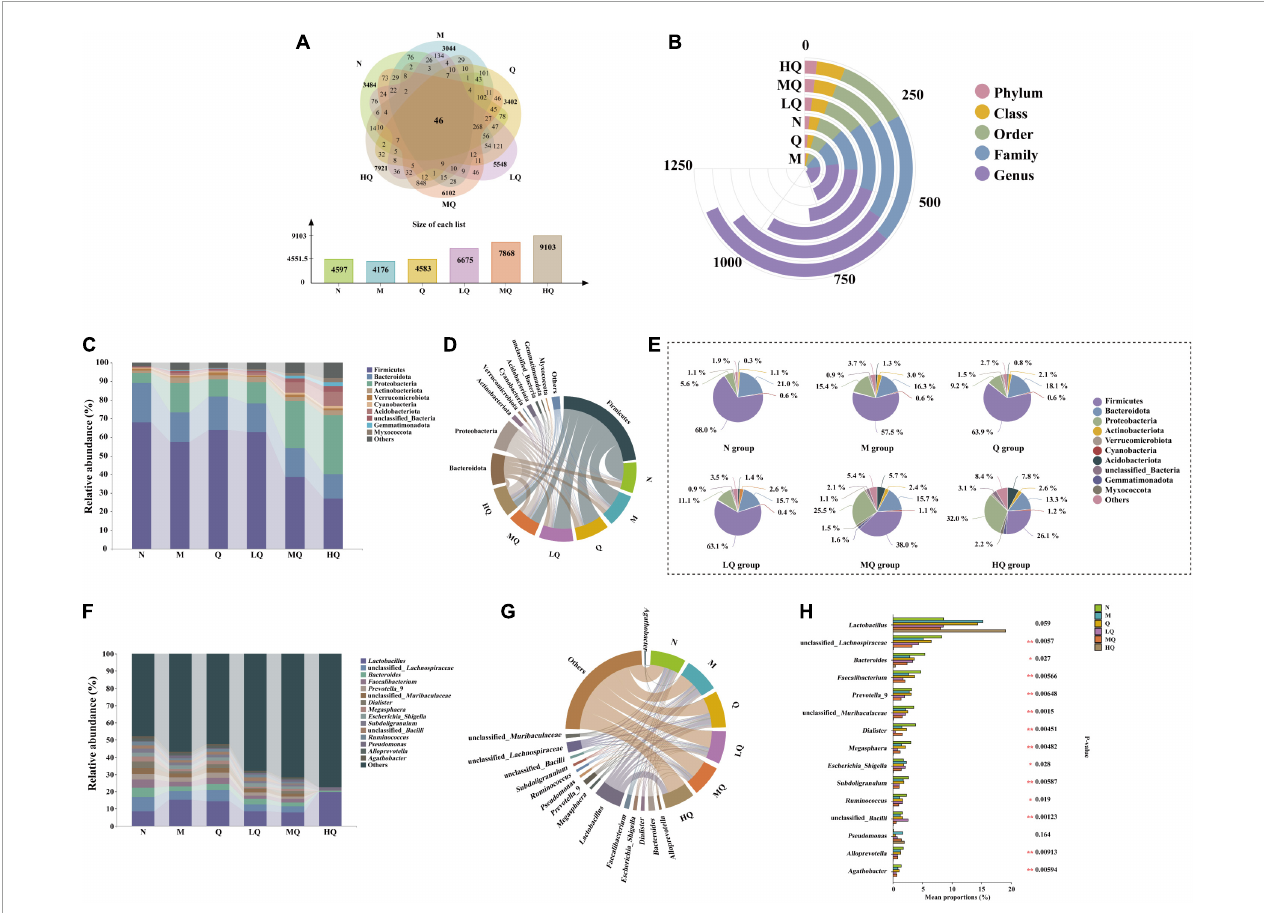
FIGURE5 Effect of different sucrose dose on the intestinal mucosal microbiota structure of mice with antibiotic-associated diarrhea (AAD) intervened by Qiweibaizhu powder (QWBZP). (A) Operational taxonomic units (OTUs) number; (B) Interactive Yujue diagram; (C) Histogram of relative abundance at the phylum level; (D) Chord diagram of the phylum level; (E) Pie chart of the phylum level; (F) Histogram of relative abundance at the genus level; (G) Chord diagram of the genus level; (H) Multi-species comparison at the genus